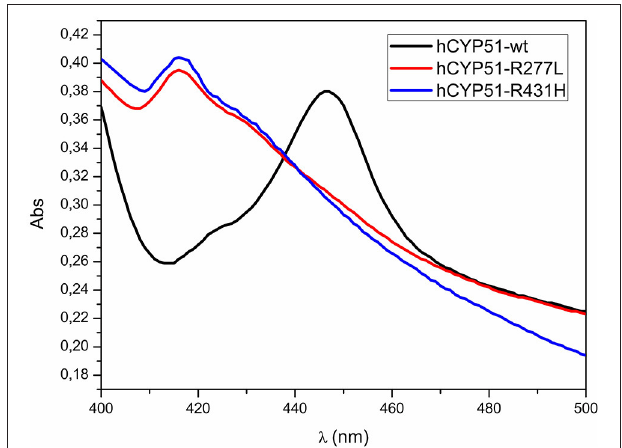
FIGURE 4 | CO-difference spectra for wild type hCYP51-wt (black line), hCYP51-R277L (red line), and hCYP51-R431H (blue line)